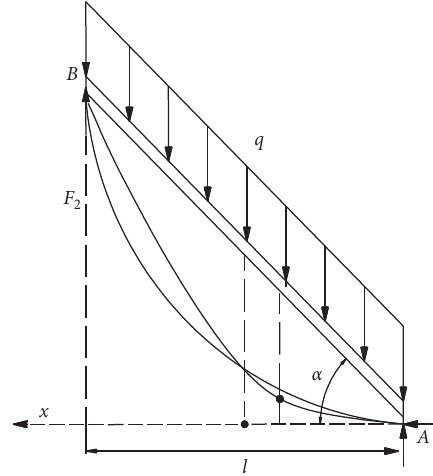
Figure 3: Stress diagram on an inclined